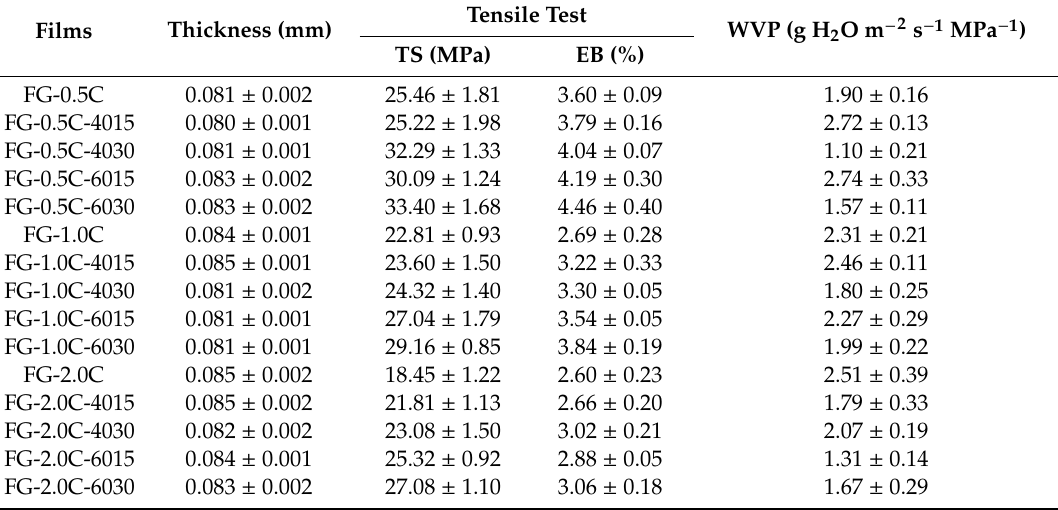
Table 2. E ff ect of sonication onthe mechanical properties and moisture resistance of flaxseed gum films incorporated with